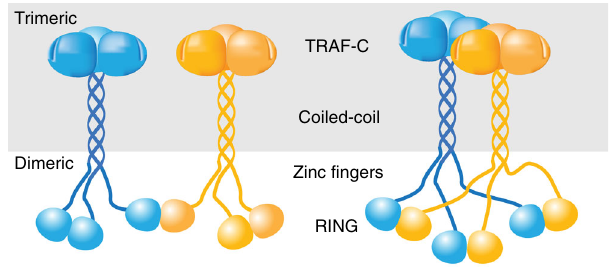
Fig. 6 Model showing how TRAF trimers might associate to enable RING dimerisation. Two potential ways that TRAF RINGs can form homo- or heterodimers that may resolve the symmetry mismatch between the trimeric TRAF-C domain and the dimeric